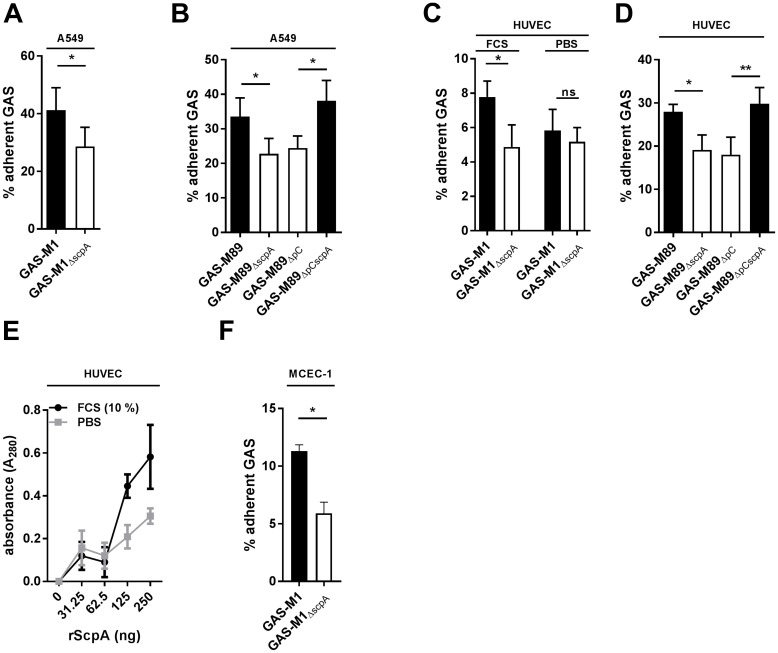
ScpA requires serum factors to mediate GAS adhesion to epithelial and endothelial cells.A+B) Adhesion of A) GAS-M1 and B) GAS-M89 and isogenic ΔscpA strains to A549 epithelial cells was compared by quantitative culture (30 min incubation). Data represent mean+/-SD of 3 experimental replicates (T-test * < 0.05). C+D) Adhesion of C) GAS-M1 and D) GAS-M89 and isogenic ΔscpA strains to primary human HUVEC was compared by quantitative culture (30 min incubation). Data represent mean+/-SD of 3 experimental replicates (T-test * < 0.05, ** < 0.001). E) Adherence of rScpA protein to paraformaldehyde-fixed human HUVEC. Bound rScpA was quantified following incubation with anti-ScpA mouse serum and goat-anti mouse HRP antibody and detection with TMB. Adhesion was compared in the presence and absence of 10% FCS. Data represent mean+/-SD of 3 experimental replicates (T-test * < 0.05). F) Adhesion of GAS-M1 and GAS-M1ΔscpA to the murine endothelial cell line MCEC-1 was compared by quantitative culture (30 min incubation). Data represent mean+/-SD of 3 experimental replicates (T-test * < 0.05).